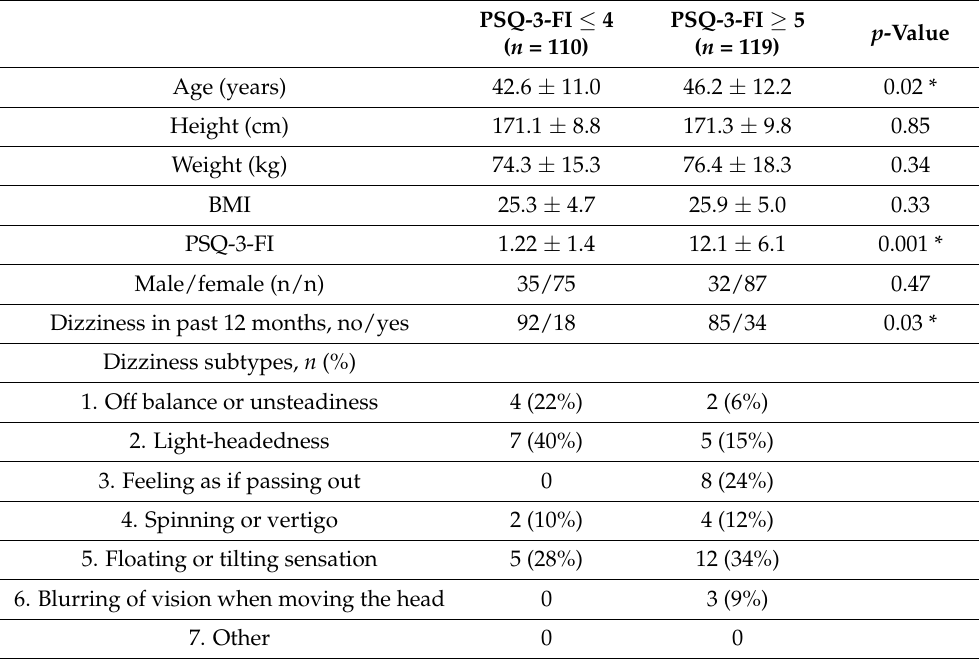
Table 5. Comparison of the PSQ-3-FI score ≤ 4 and ≥ 5 groups ( n = 229).